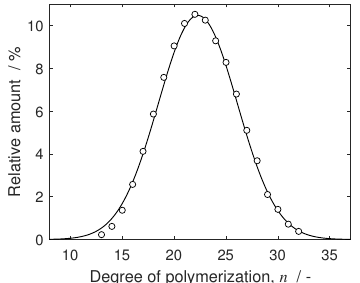
Figure 1. MWD of PEG 1000 determined by LC/MS (symbols) and interpolation by a normal distribution (line; mean value 22.285, standard deviation 3.81). Measured using the analytical column (eluent 20 vol% ACN, 1 mL/min; 25 ◦ C; injection 10 µ L of 1 g/L PEG 1000 in